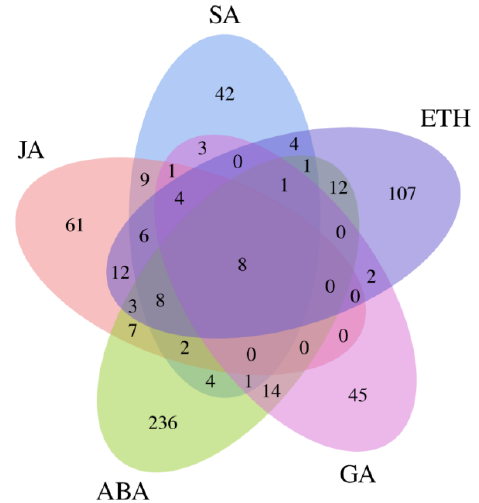
Figure 8. Venn diagram of DEGs in hormone signal transduction pathway across three time points (0, 1, and 3 days) after SpM infection in resistant (GUIGE18) and susceptible cultivars (GUIGE8). JA—jasmonic acid; SA—salicylic acid; ETH—ethylene; GA—gibberellic acid; ABA—abscisic acid.